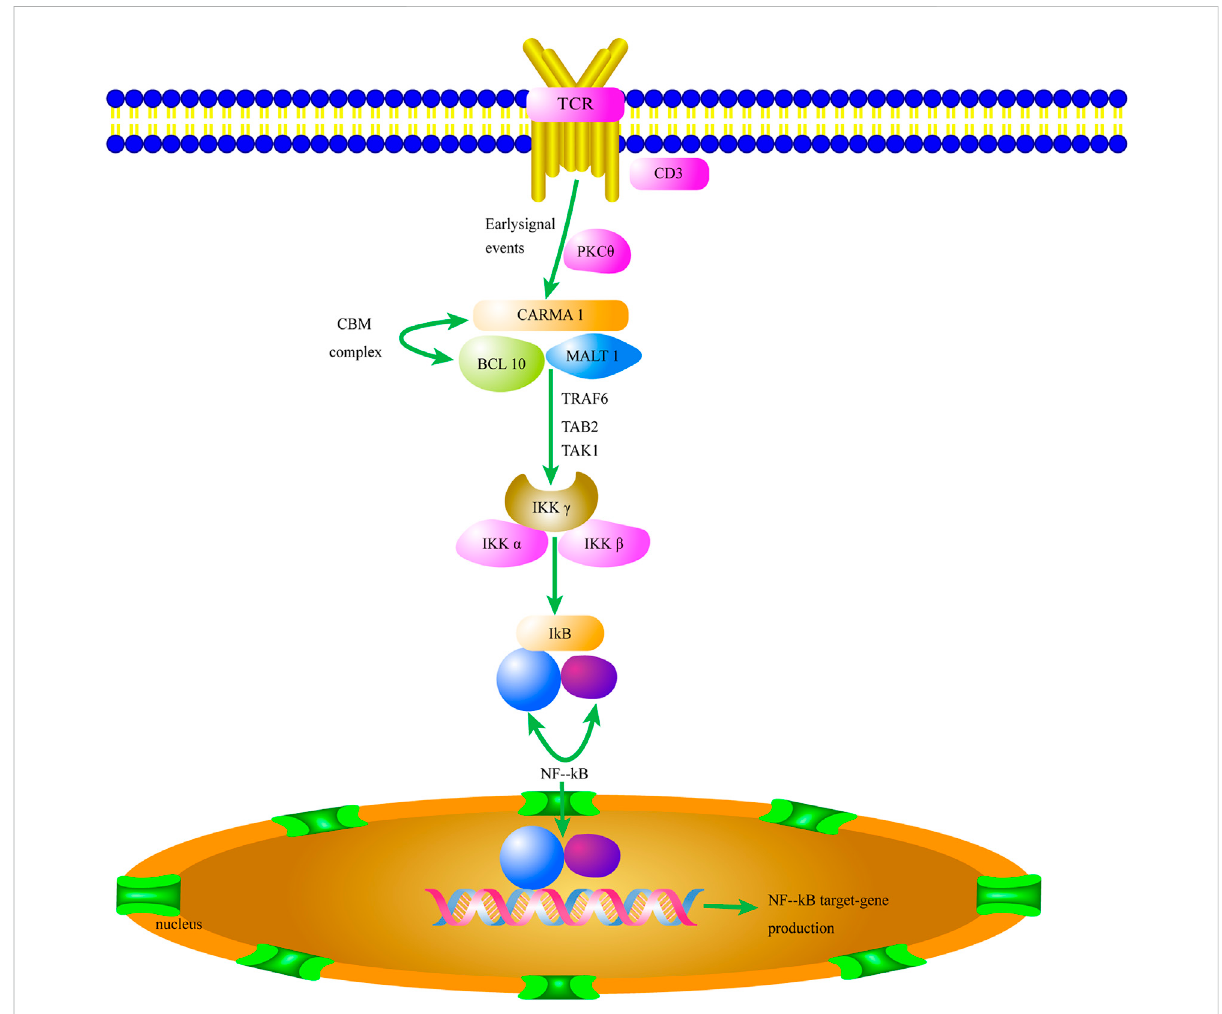
FIGURE 2 The CBM complex/NF- κ B signaling pathway of Tregs contributes to the tumor microenvironment. Activation of the CBM complex/NF- κ B signaling pathway in Tregs increases HIF-1 α and IL-6 expression and initiates the TME. The secretion of HIF-1 α and IL-6 in the TME promotes Treg proliferation and migration. TCR, T cell receptor; PKC, Protein kinase C; CARM1, Caspase recruitment domain-containing membrane-associated guanylate kinase protein-1; BCL10, B-cell lymphoma/leukemia 10; MALT 1, Mucosa-associated lymphoid tissue 1; TRAF6, TNF receptor associated factor 6; TAK1, TGF β -activated kinase 1; TAB2, TAK1-binding protein 2; I κκ , inhibitor of kappa kinase; NF-kB, nuclear factor kappa